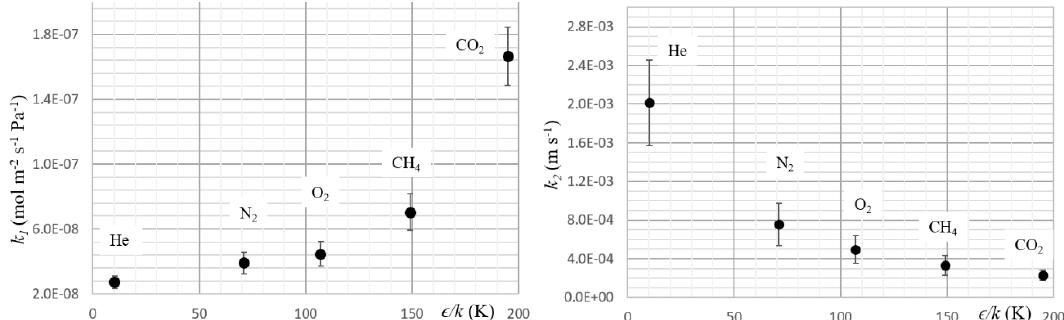
Figure 3. Surface kinetics parameters vs Lennard–Jones temperature. Graphs show the dependence of k 1 and k 2 on Lennard–Jones temperature ϵ / k .